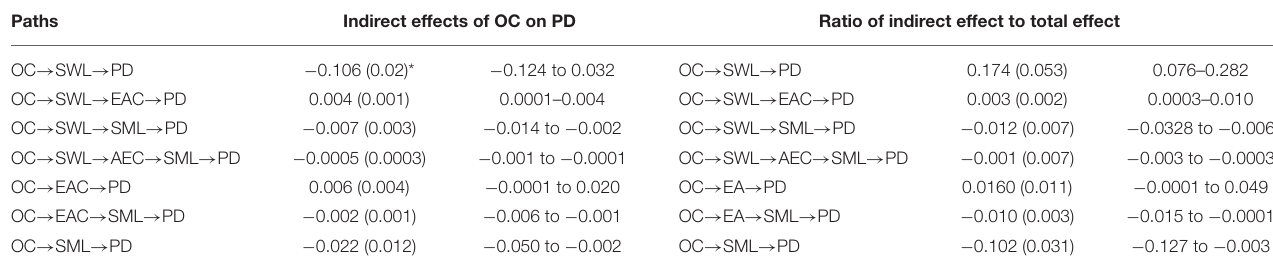
TABLE 3 | Standardized mediational effects of obsession on psychological distress in serial mediation model. Paths